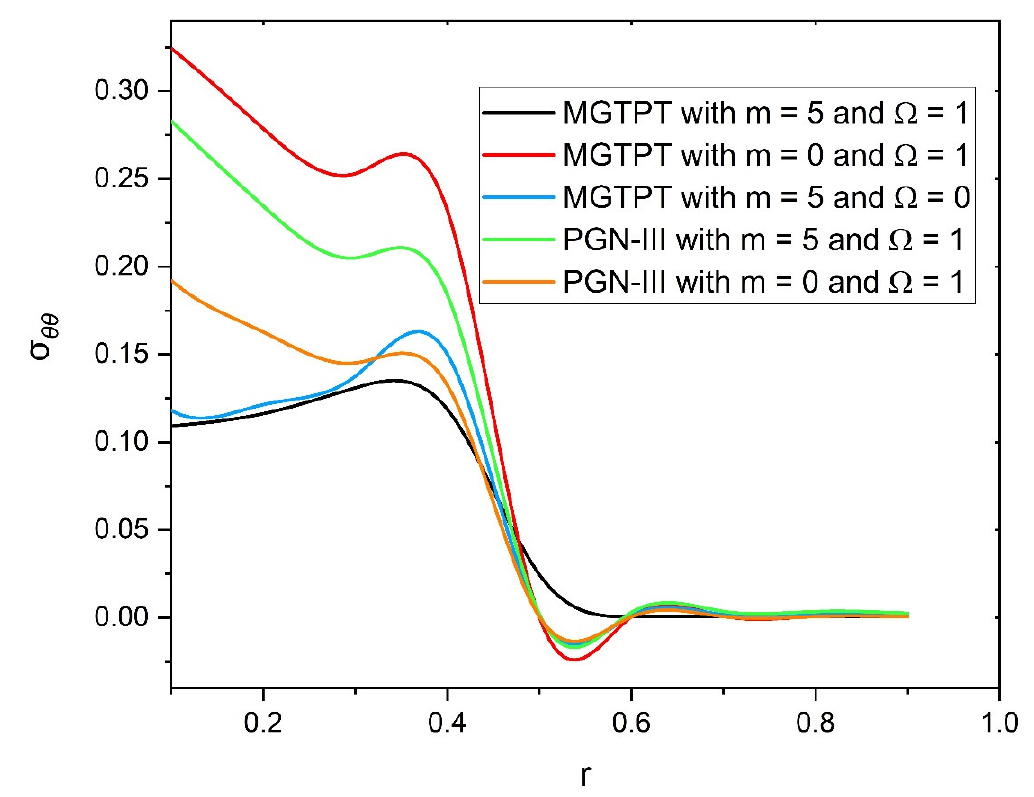
Figure 6. The deviation in hoop stress for various models with Hall effect and rotation.